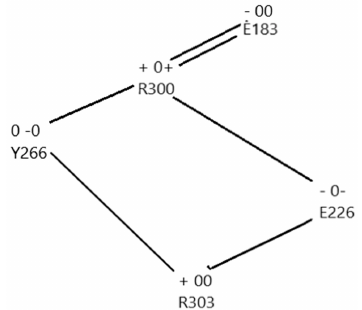
Figure 6. Two paths from R303 to R300, and then on to E183. The single lines represent one of the paths, the double lines mean both paths follow that step. The left symbol gives the nominal charge on that amino acid in the closed state, the right two symbols give the charge in one path each, with the left charges all for the same path, and the right charges all for the same path (e.g., E183–00 means E183 is negatively charged in the closed state, and neutral in both paths to the open state). Actual charges as calculated by NBO (Natural Bond Orbital) are fractional, but of the sign shown. The proton follows the charges as shown. In the closed state, the S176 –OH is oriented so as not to form a hydrogen bond with R303 in the closed state, and oriented to form such a bond in either path of the open state, thus altering the local field.